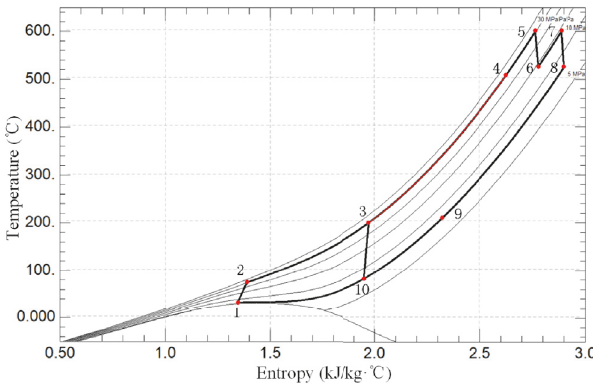
Figure 2: T-s diagram of recompression S-CO 2 Brayton cycle with single